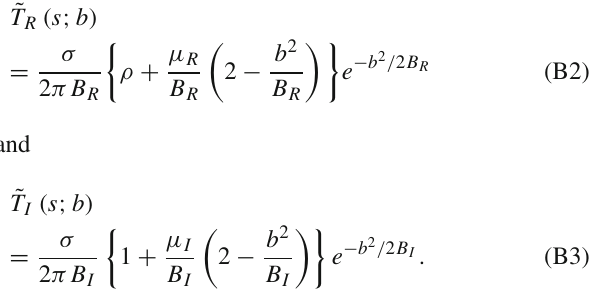
√ ˜ T at s = 8 TeV as a function of b for T8